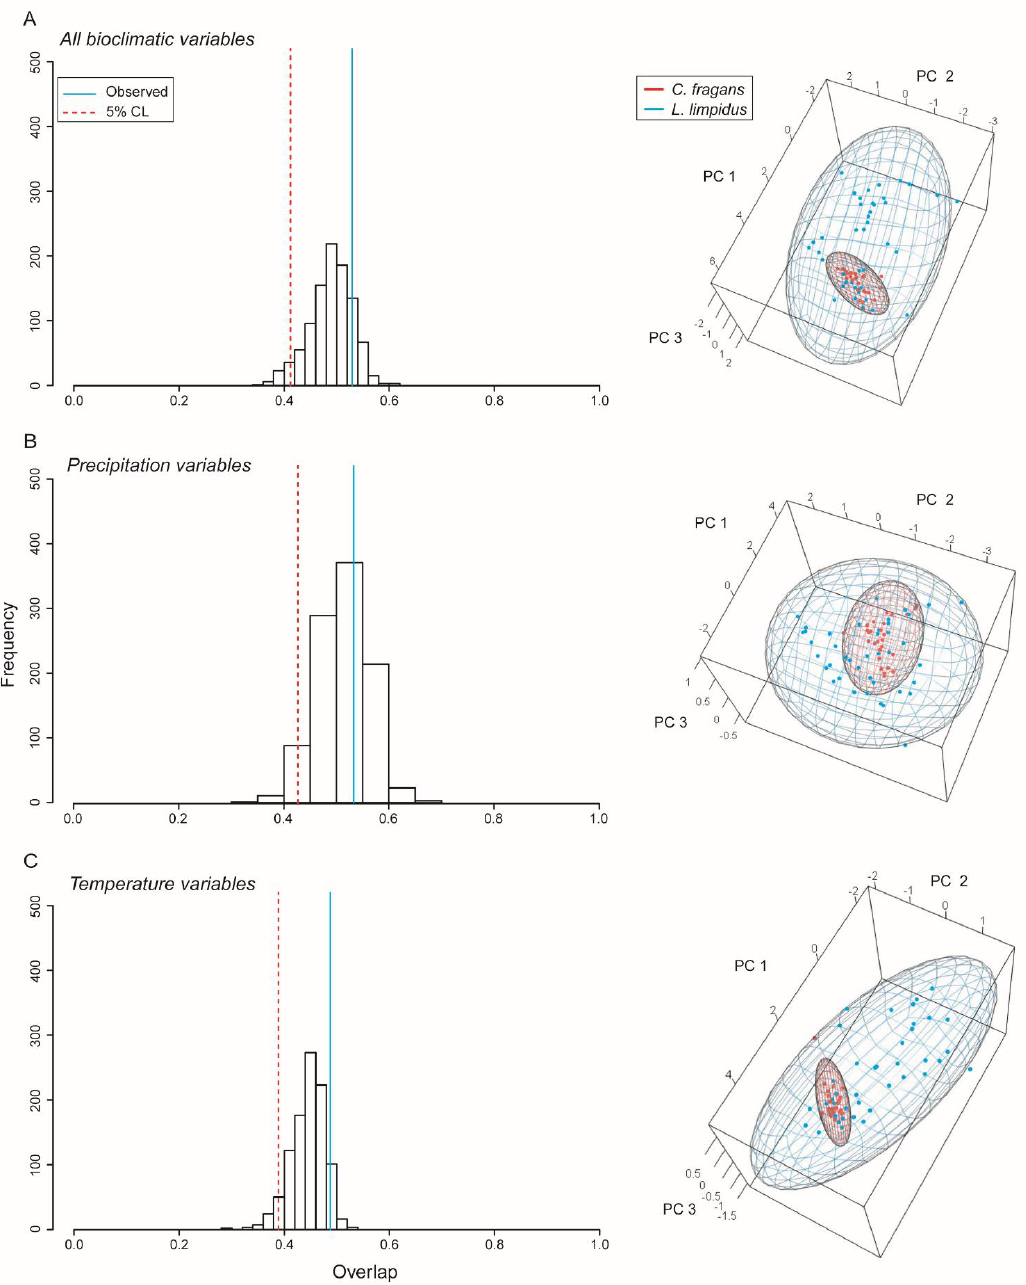
Figure 3. Niche overlap between the longhorn beetle Lepturges limpidus and its known hostplant Catostemma fragrans. Blue and red points represent occurrences for L. limpidus and C. fragans , respectively. Histograms show overlap and significance ( left ) and ellipsoid models indicating overlap in environmental space ( right ). ( A ) Results using all bioclimatic variables, ( B ) Precipitation variables, and ( C ) temperature variables.